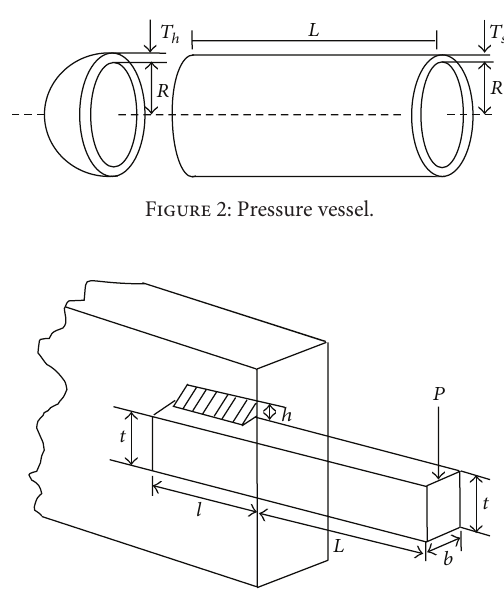
Figure 3: Schematic diagram of welded